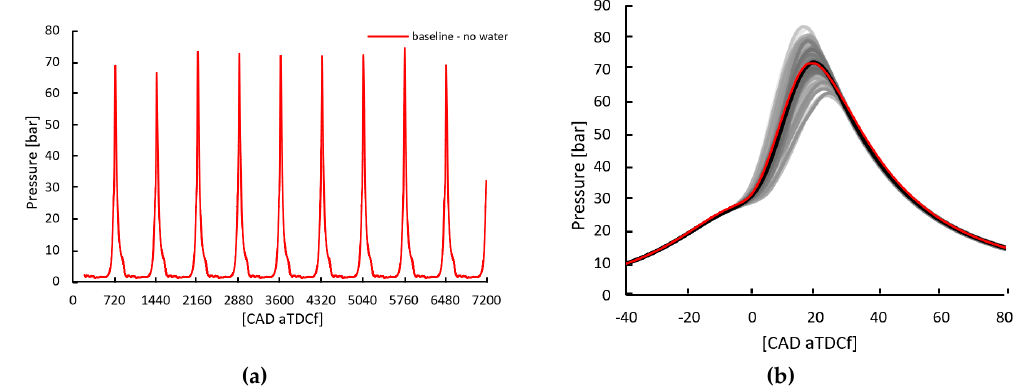
Figure 5. Example of multi-cycle simulations for the baseline configuration without water injection ( a ), and comparison of measured pressure (average curve in black, 200 cycles in gray) vs. simulated in-cylinder pressure (in red) ( b ).